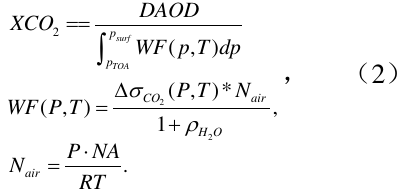
Figure 2 Block diagrams of the IPDA lidar system Table1 Specifications of the lidar